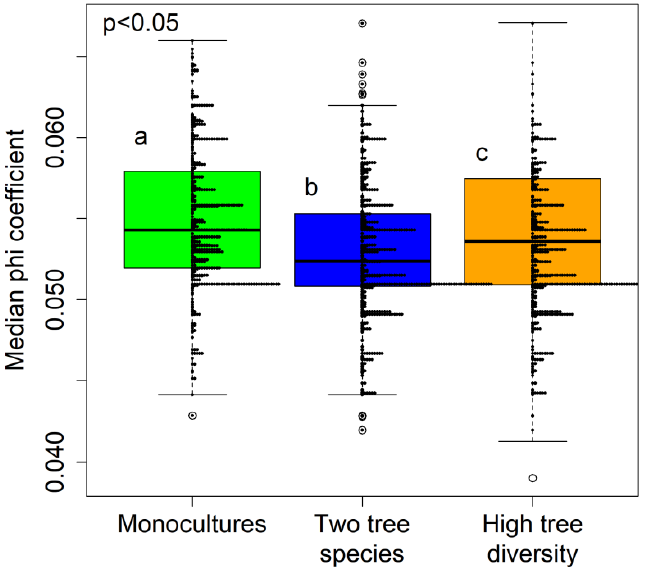
Figure 3. Boxplots of phi coefficients for the three tree diversity levels, with histogram of the results of all subsampling combinations indicated as horizontal arrays. The Kruskal-Wallis rank sum test and Kruskal-Wallis test for multiple comparisons were used to evaluate the significance of group differences; a, b, and c indicate significantly different groups.